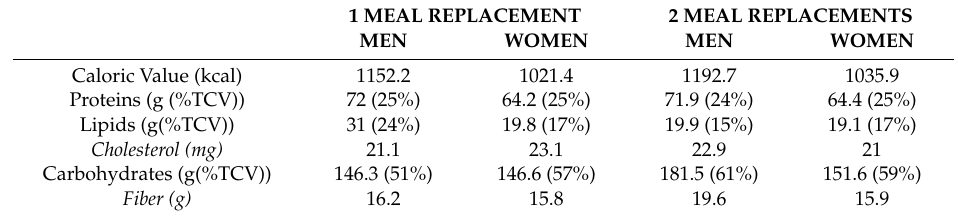
Table 1. Composition of the two randomized interventions: 1 meal replacement and 2 meal replacements. 1 MEAL